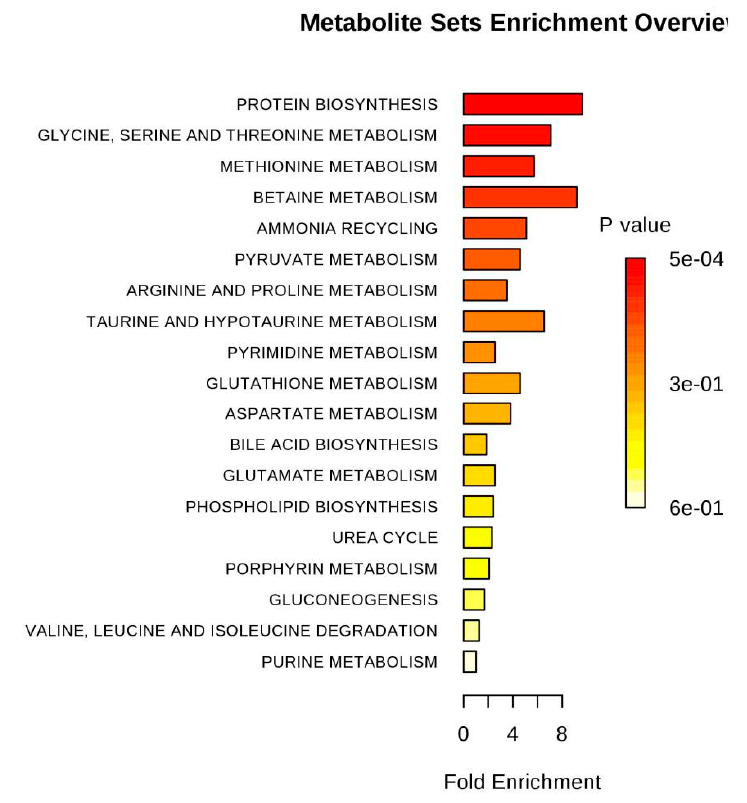
Figure 10. Pathway enrichment of di ff erences metabolites between LPS and control groups.